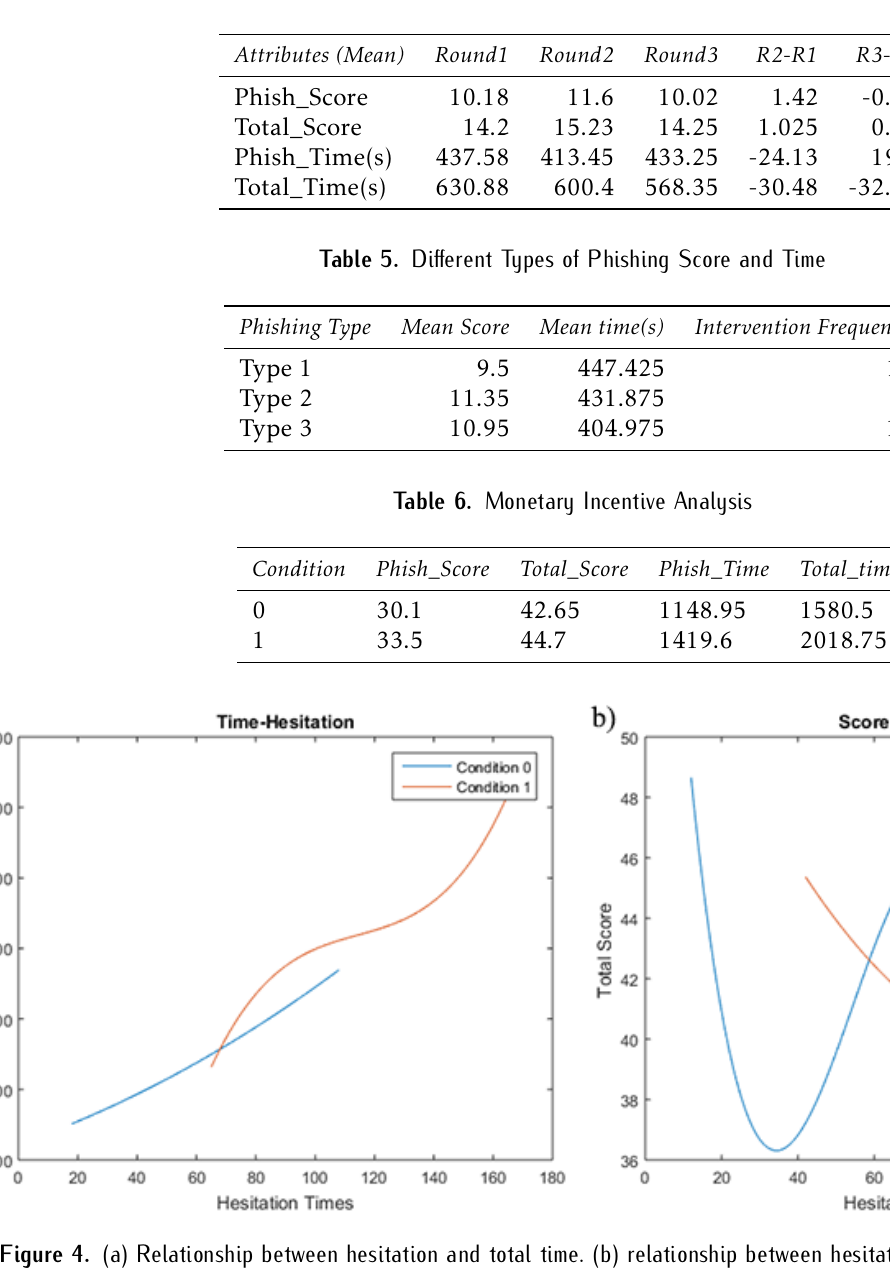
Table 4. Email Round Score and Time